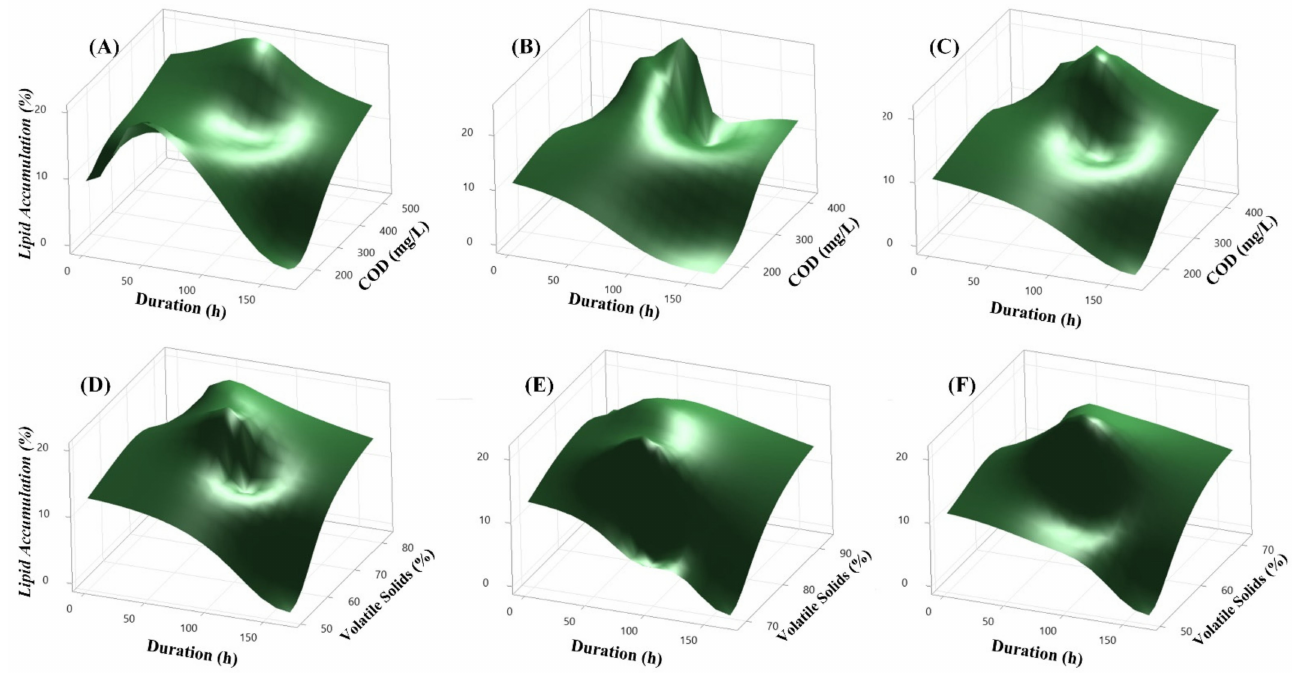
Figure 3. Surface Plot of Lipid Accumulation by bacterial isolate AF3 in different types of waste vs. COD and Volatile solids: ( A ) COD in AW, ( B ) COD in MW, ( C ) COD in OW, ( D ) Volatile solids in AW, ( E ) Volatile solids in MW and ( F ) Volatile solids in OW.